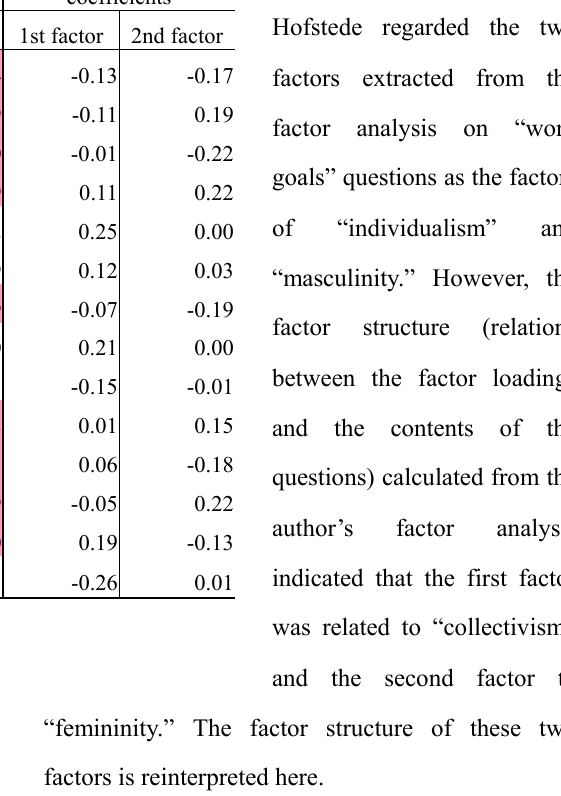
Table A3.1. As for the factor loadings and the standardized scoring coefficients of the first factor, signs were reverse to the calculation result of Hofstede. Because factor loadings are, so to speak, the weight coefficients of the common factor in each variable or the correlation coefficients between standard scores and factor scores, the signs of data do not determine the signs of factor loadings. Therefore, there are no relations between the reverse of Likert scale and inconsistency of the signs of the factor loadings and the standardized scoring coefficients of the first factor; they are multiplied by minus 1 for some other reason.